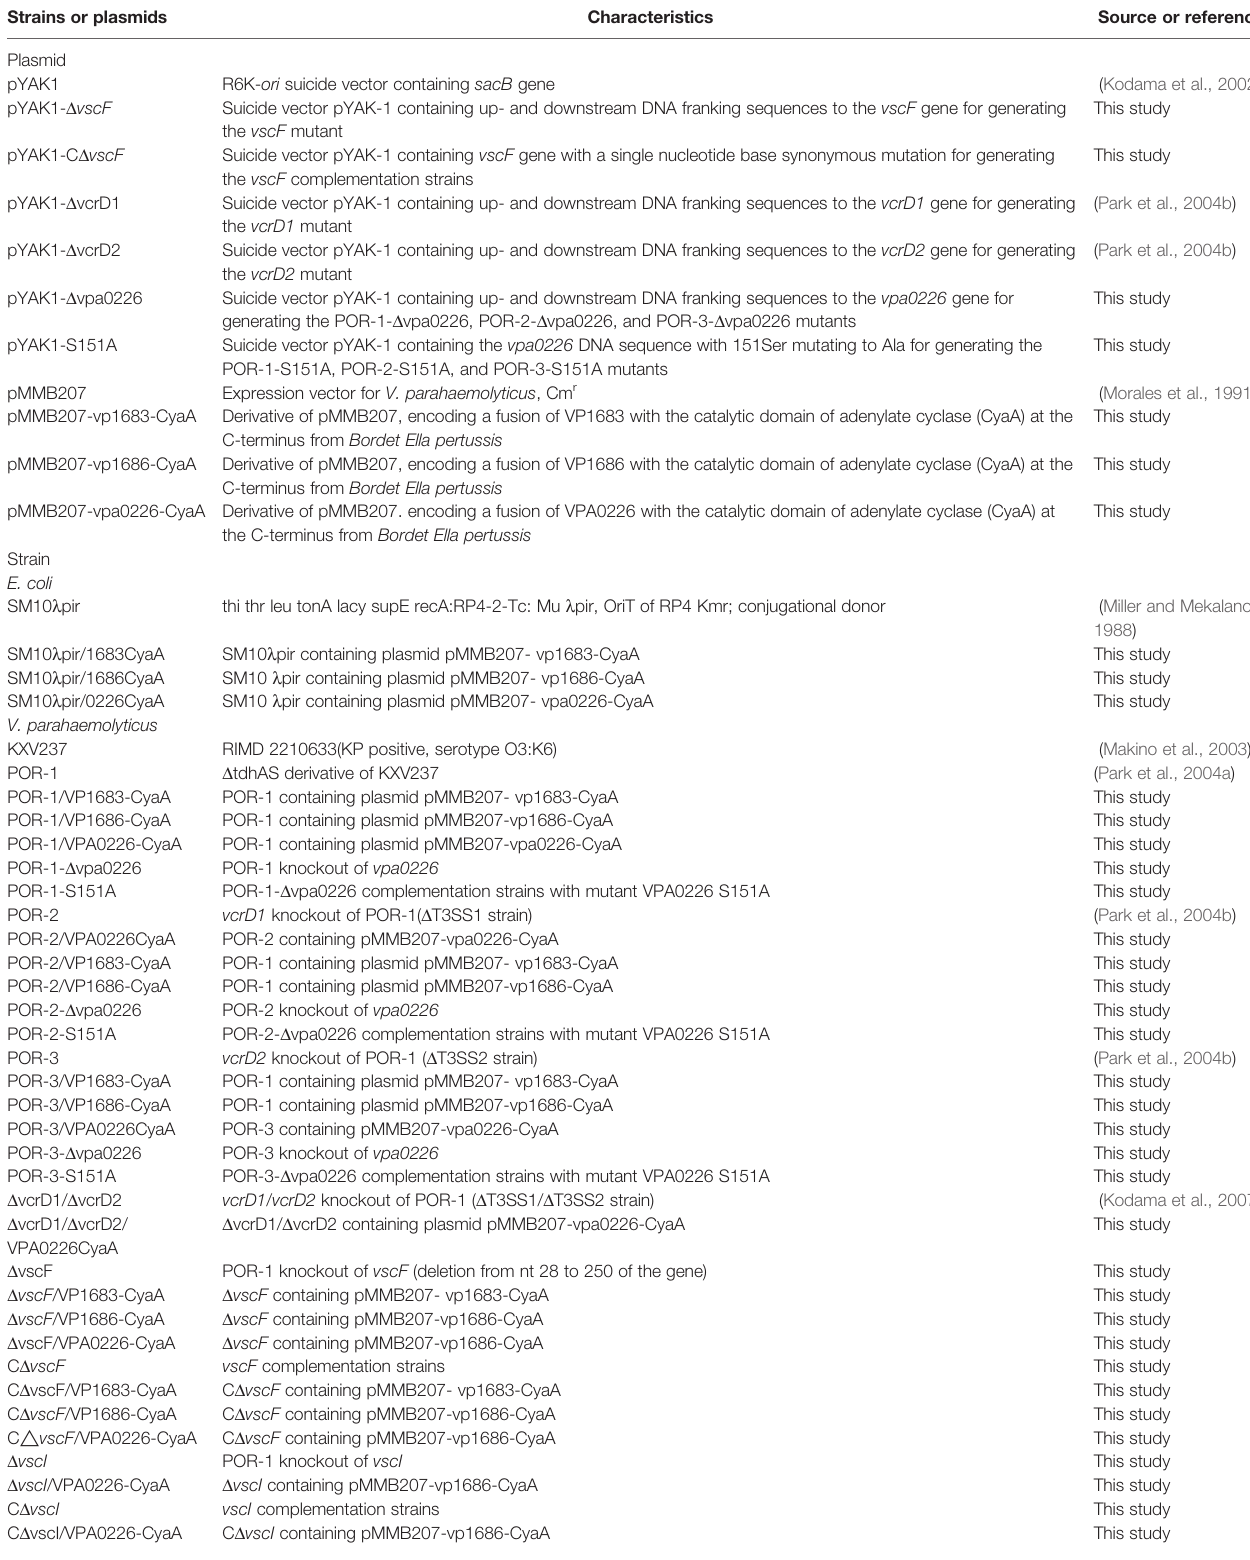
TABLE 1 | Plasmids and bacterial strains. Strains or